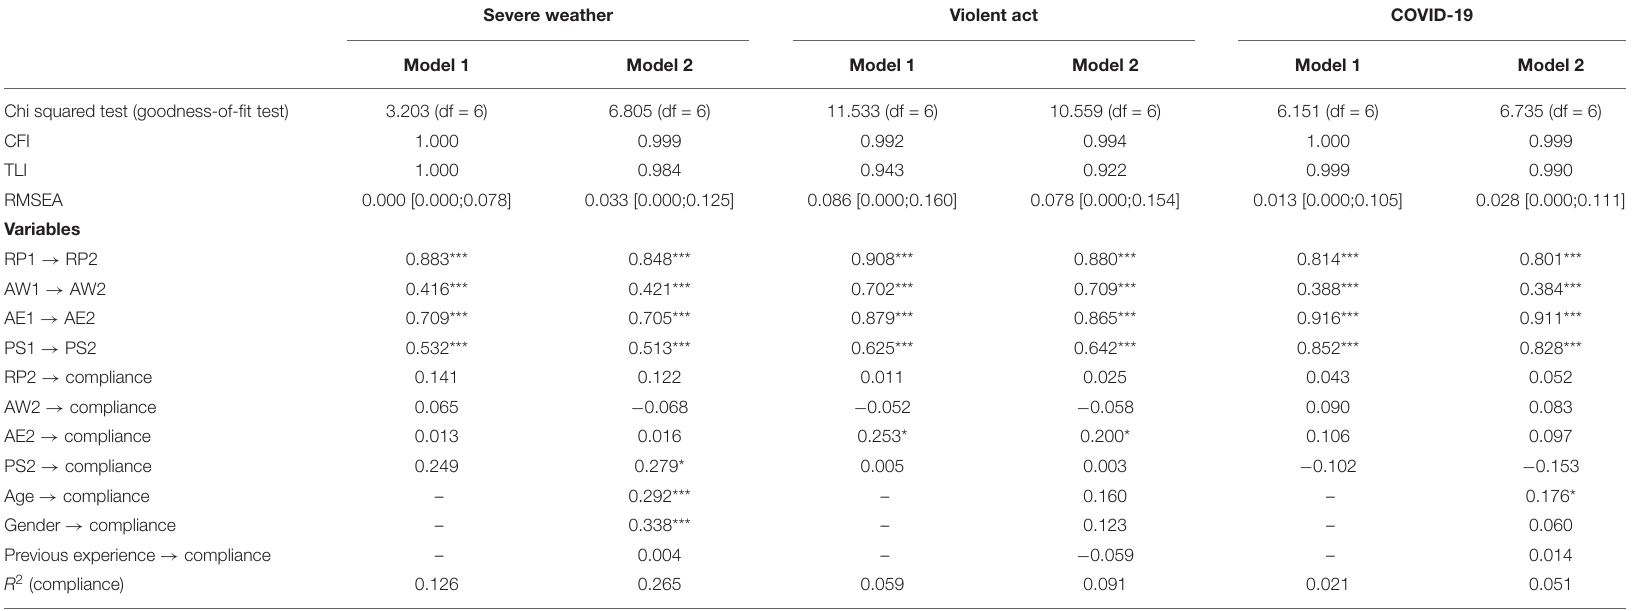
TABLE 3 | Path models for the hazard types severe weather, violent act, and COVID-19, with (model 2) and without age, gender, and previous experience (model 1) as